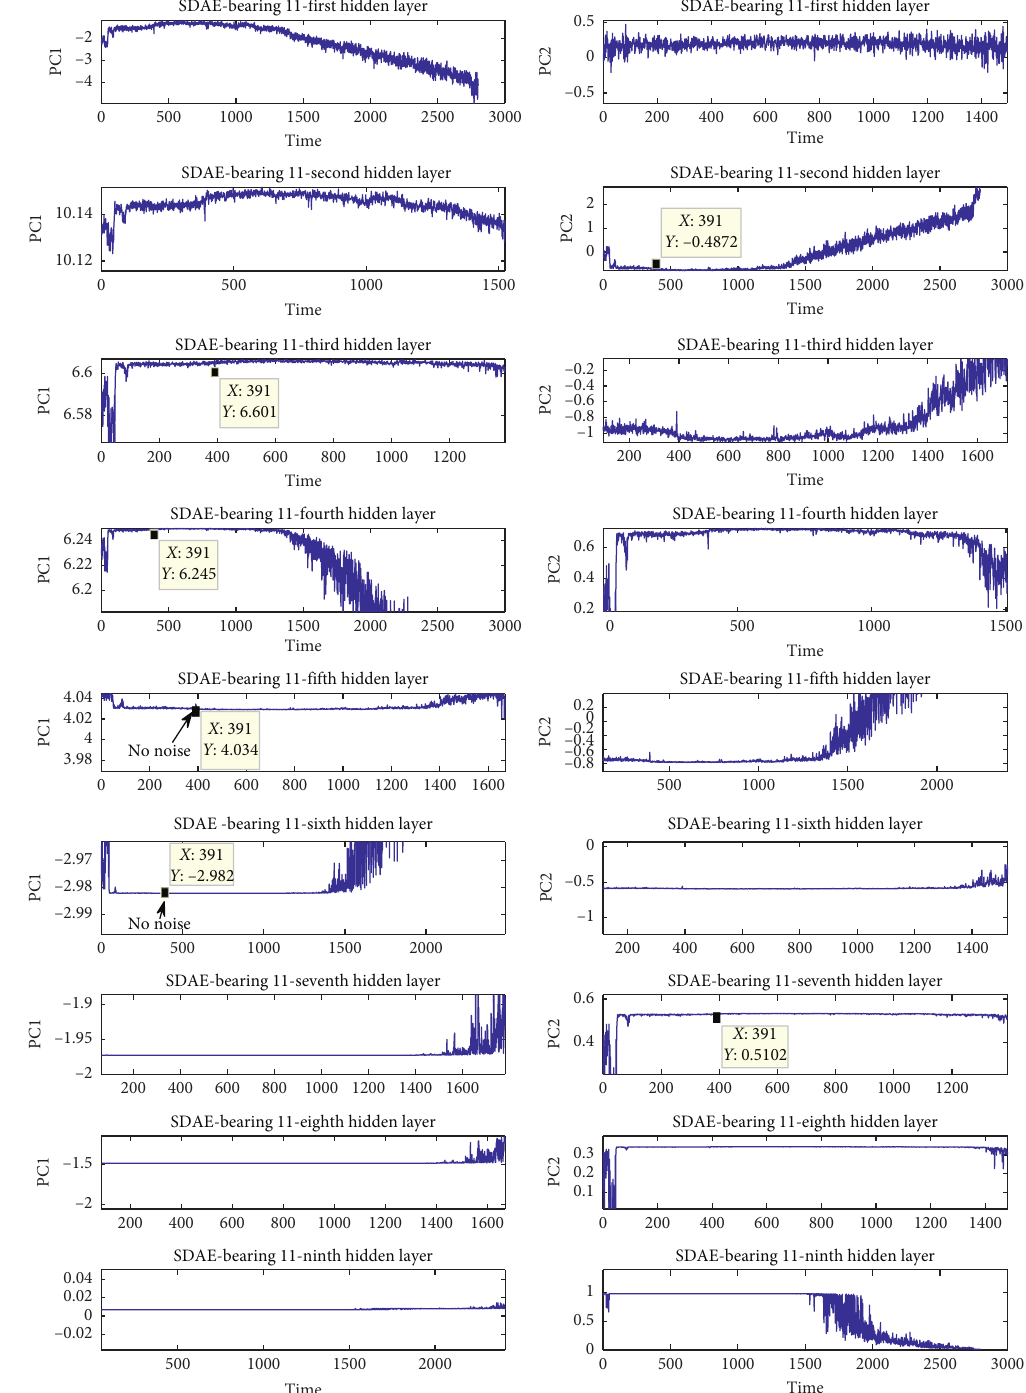
Figure 9: Extracted degradation through every hidden layer for bearing 11 by using the